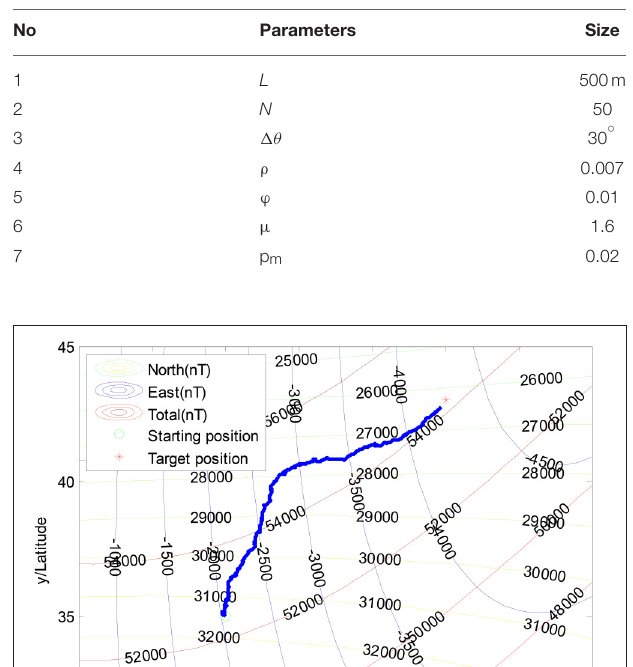
TABLE 1 | Setting navigation parameters.